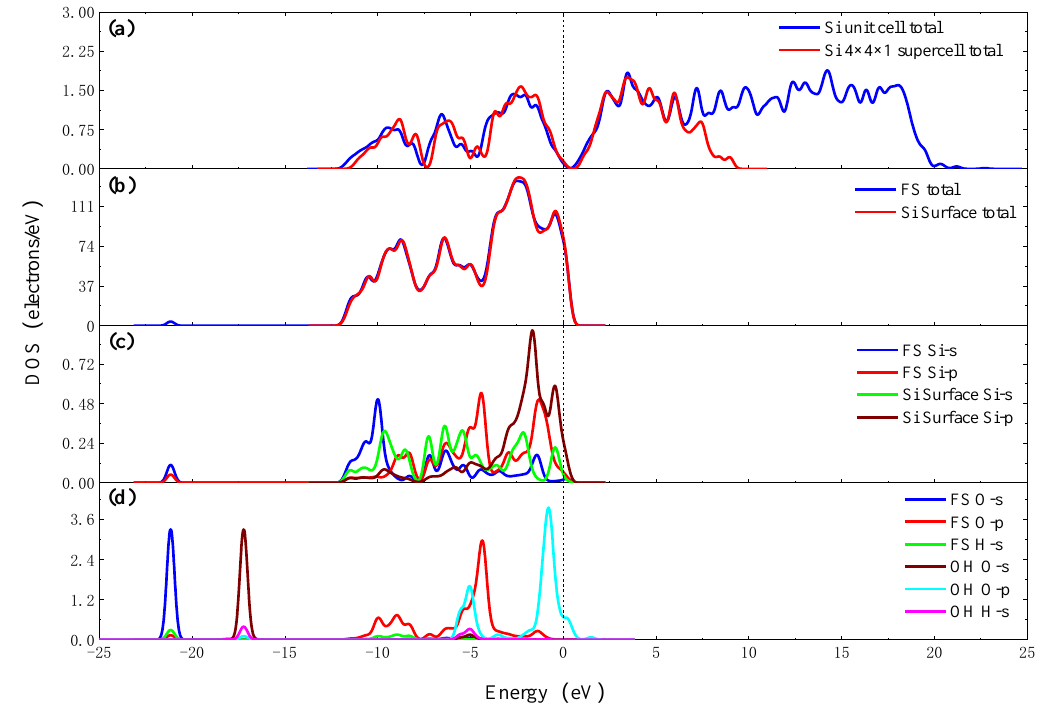
Figure 6. The DOS of OH group adsorbing on the Si surface. ( a ) Total DOS of Si unit cell and 4 × 4 × 1 supercell; ( b ) total DOS of FS and Si surface; ( c ) PDOS of adsorption site Si atoms of FS and Si surface; ( d ) PDOS of O atom and H atom of FS and OH group.